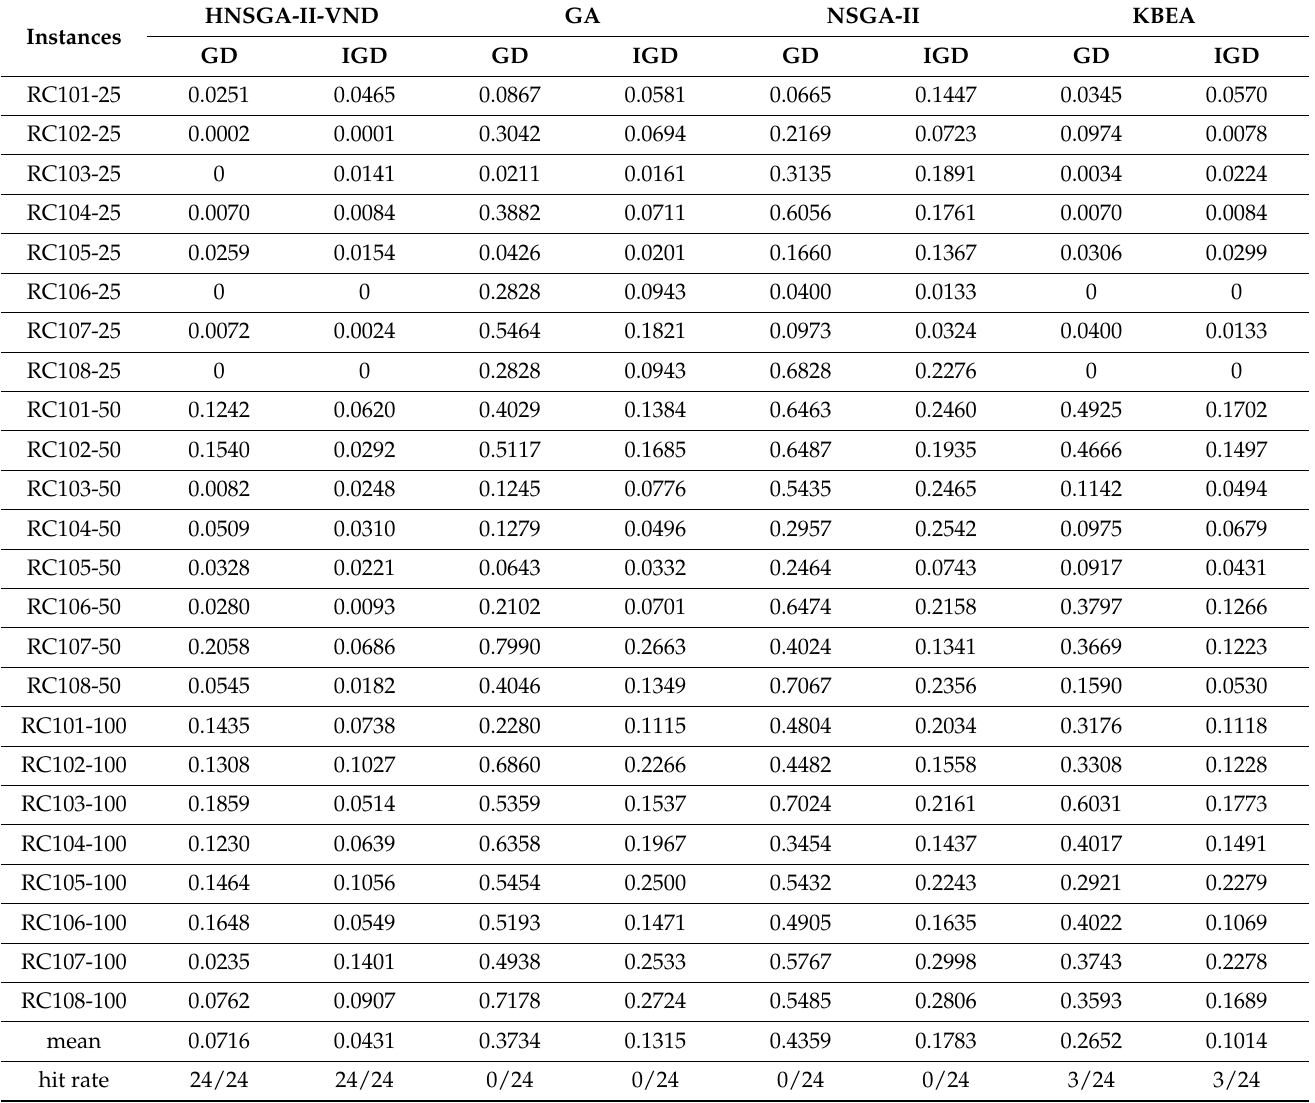
Table 8. The index values of all comparison algorithms in RC